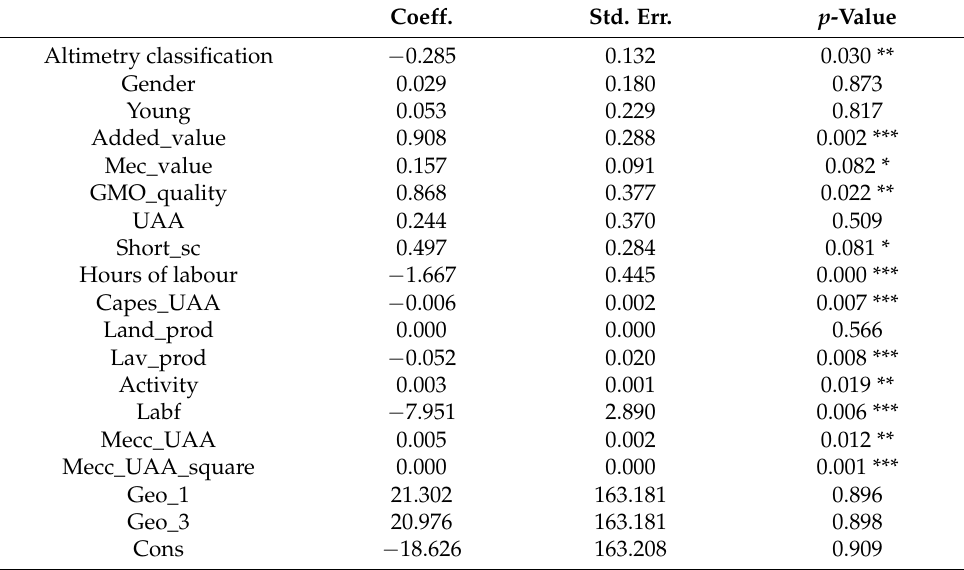
Table 6. Estimates on probability to adopt organic certification. Coeff. Std. Err. p -Value